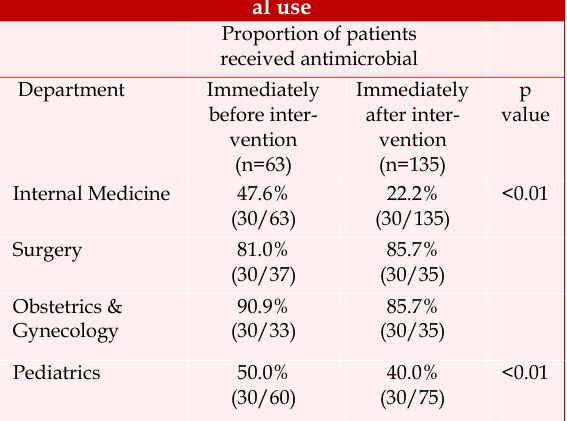
Effect of intervention on proportion of